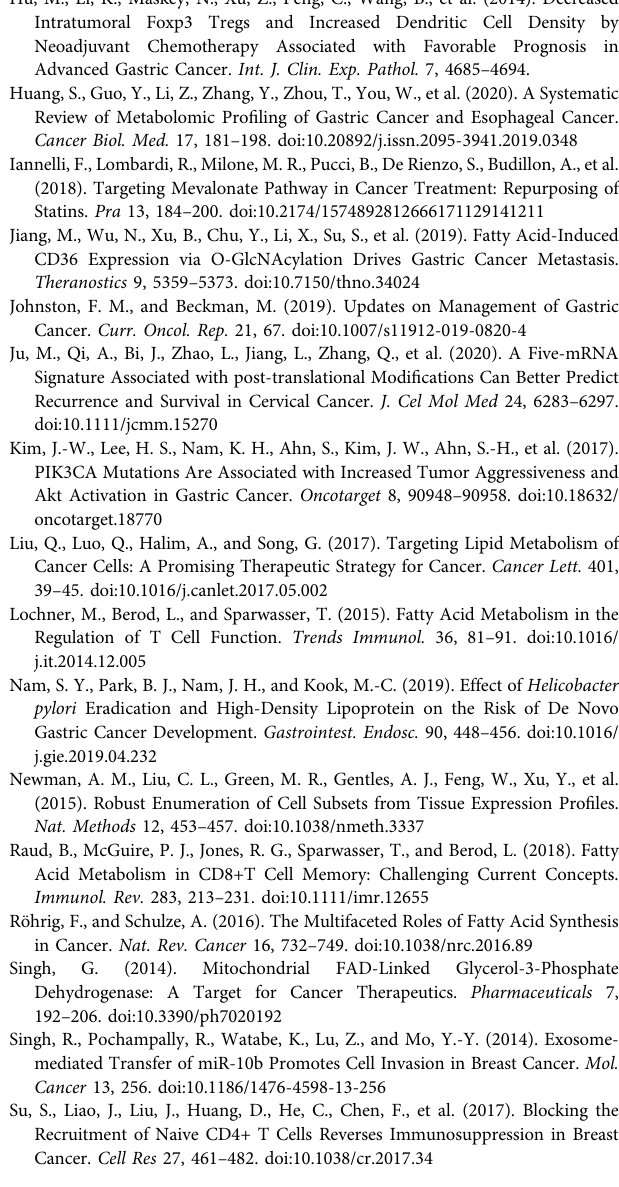
Supplementary Figure 5 | Expression of 19 genes (A) , continuous patient risk score (B) , and survival state (C) in both datasets. Supplementary Figure 6 | Decision curve analysis (DCA) for 3-year OS and 5-year OS. DCA for 3-year OS in the training dataset (A) , validation dataset (B), and both datasets (C) ; DCA for 5-year OS in the training dataset (D) , validation dataset (E), and both datasets (F)